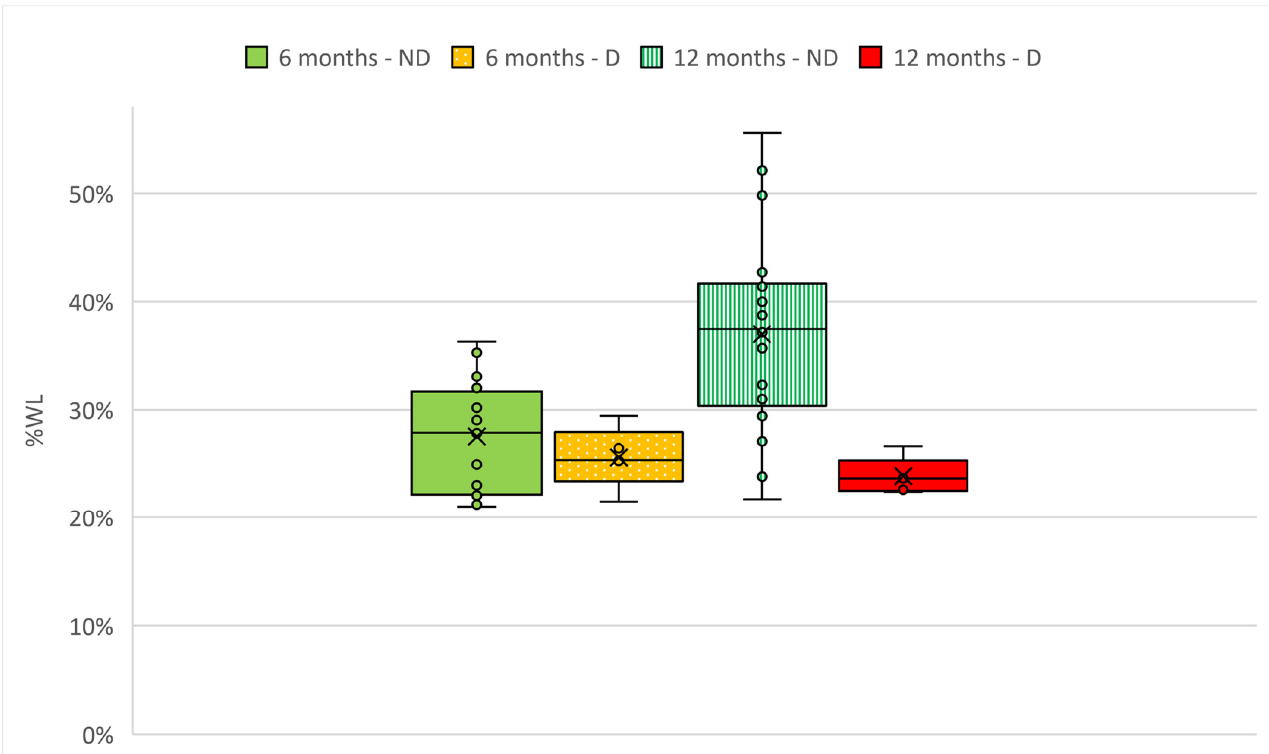
Figure 1. Percentage of weight loss (%WL) after bariatric surgery in two groups of adults with obesity. Patients were divided in two groups ND (Non-deleterious) and D (Deleterious), based on the pathogenicity classification of the genetic variant identified with the NGS sequencing. Data were analyzed with independent samples t -test analysis, with p ≤ 0.05.